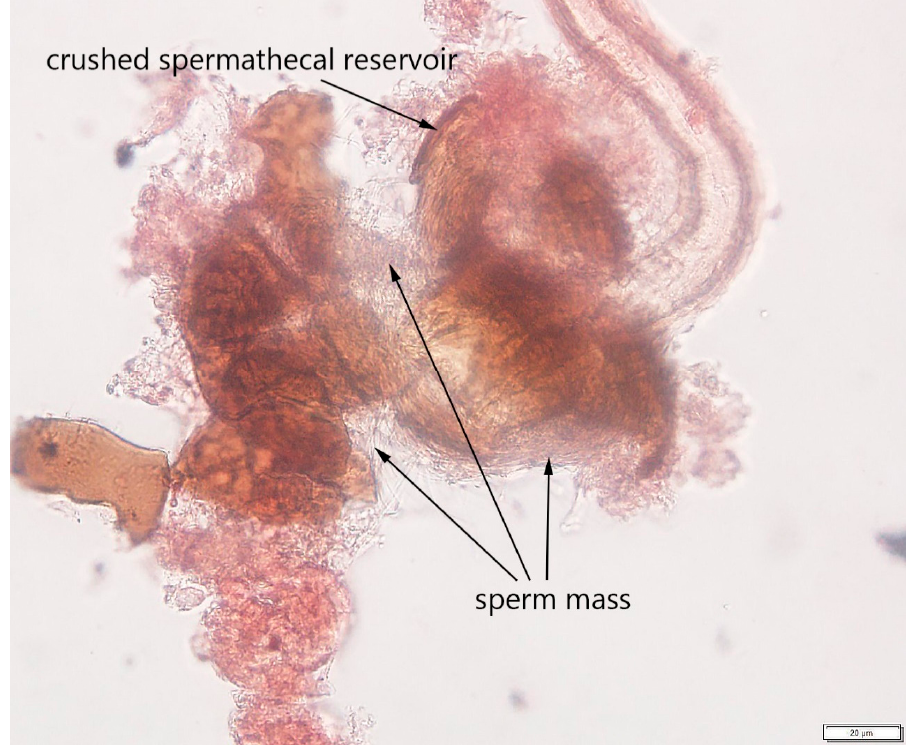
Figure 4. A crushed spermatheca of a mated Drosophila suzukii female observed under the compound microscope at 40× objective lens. The toroidal sperm mass is indicated with arrows; the scale is 20 µm (Image by Alina Avanesyan).